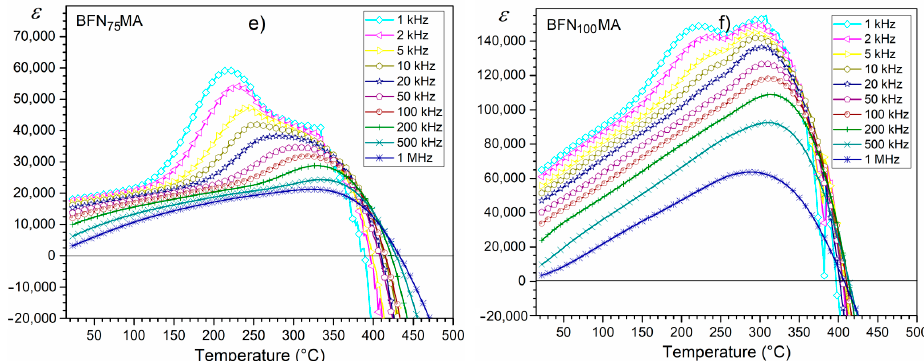
Figure 5. Temperature dependencies of electric permittivity for BFN x MA ceramic samples: BFN 10 MA ( a ), BFN 20 MA ( b ), BFN 40 MA ( c ), BFN 60 MA ( d ), BFN 75 MA ( e ), and BFN 100 MA ( f ).